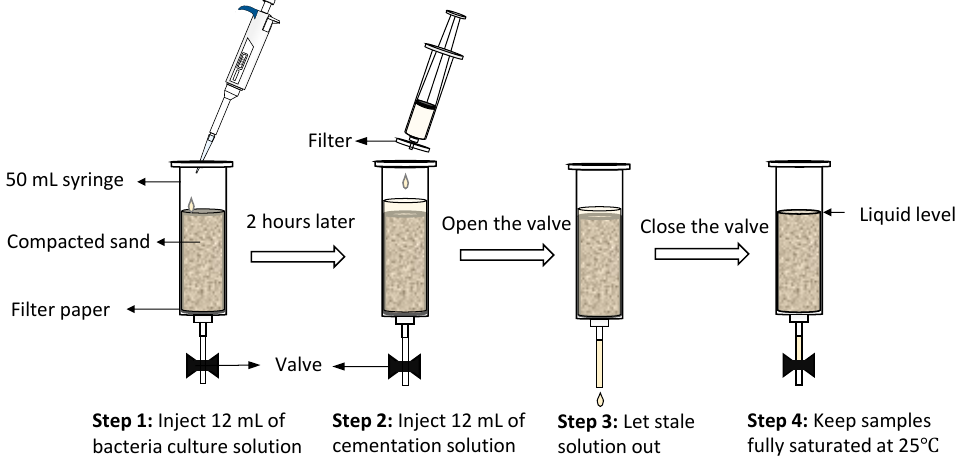
Figure 3. MICP treatment processes.